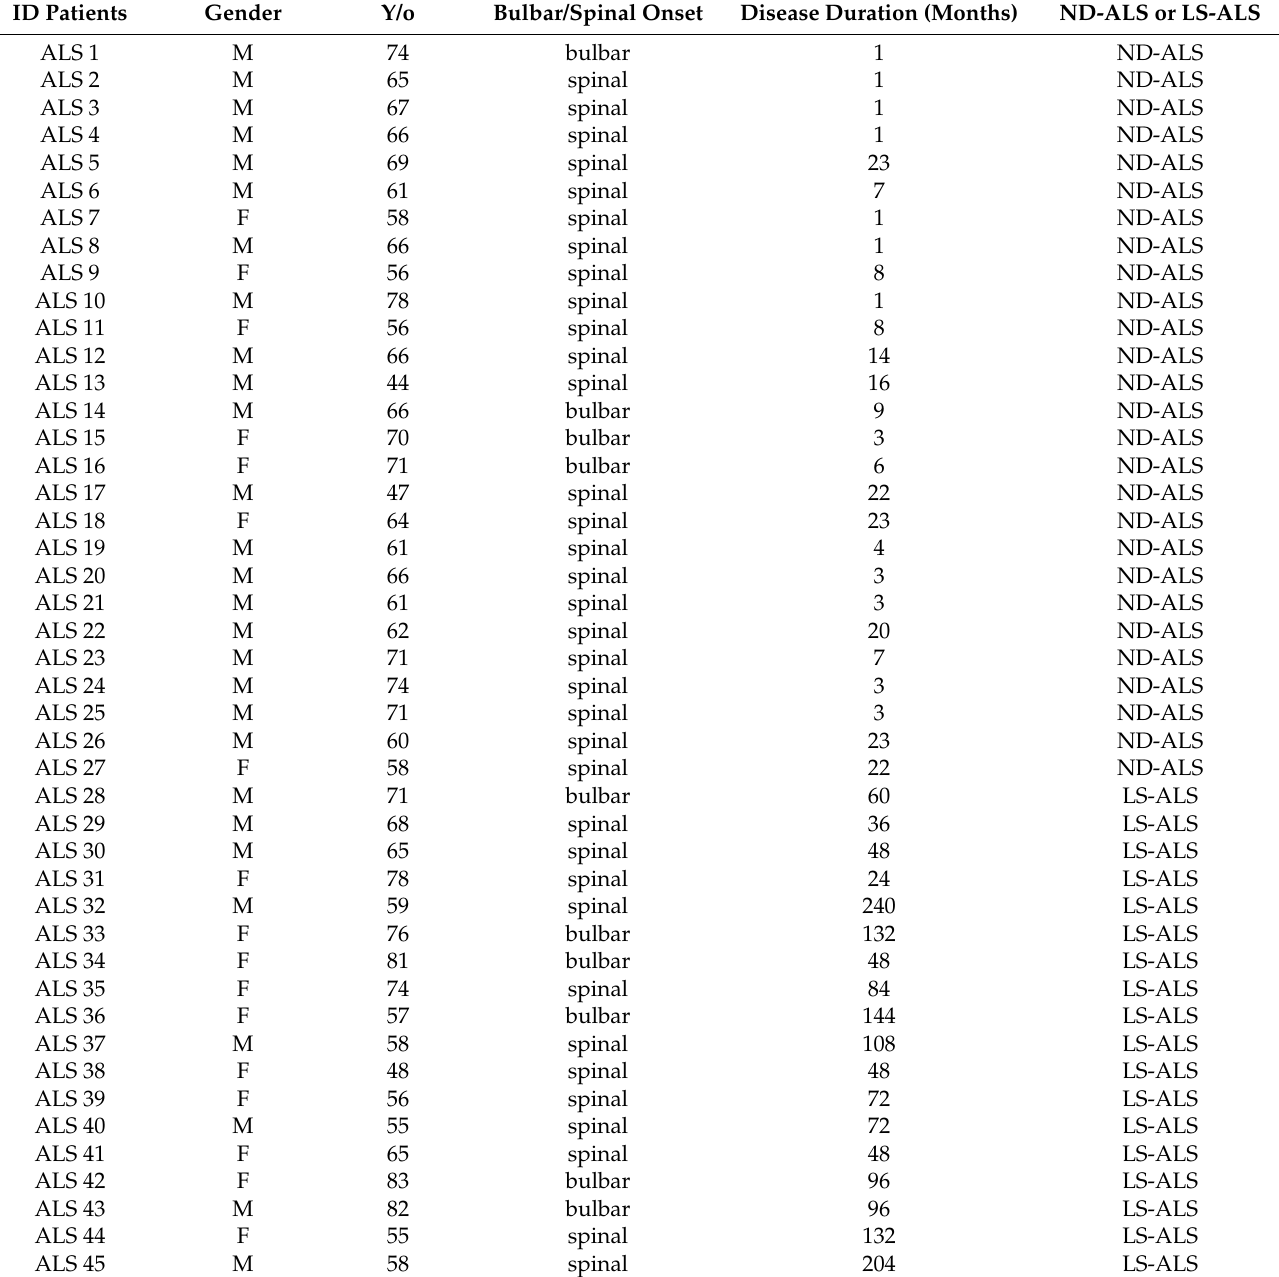
Table 3. ALS patients’ clinical